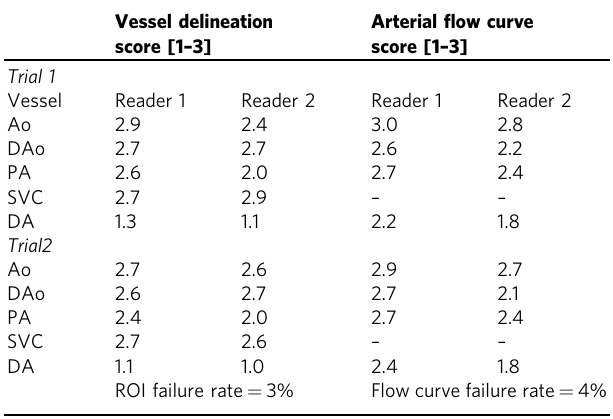
Table 1 Expert reader scores of vessel delineation and assessment of phasic behavior in arterial fl ow